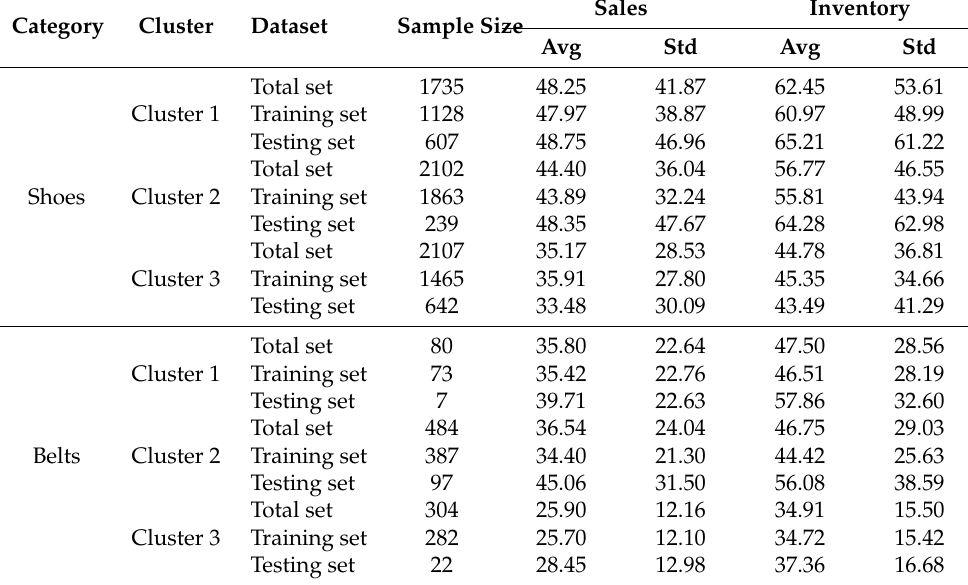
Table 3. Statistic characteristics of